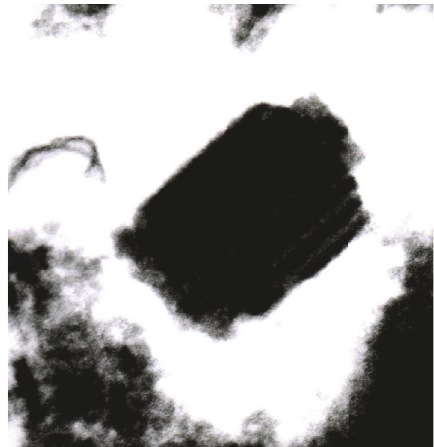
Figure 6: Ultrastructurally, near rhomboid crystalline structures were